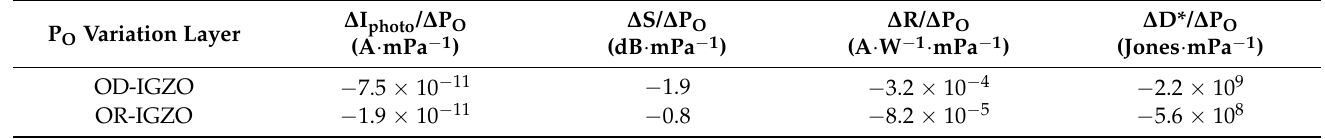
Figure 2. Dependence of the oxygen partial pressures for OD-IGZO on ( a ) I photo /S and ( b ) R/D* of the DSCL-TFTs; dependence of the oxygen partial pressures for OR-IGZO on ( c ) I photo /S and ( d ) R/D* of the DSCL-TFTs. Table 2. Variations of the UV light detecting performances with Δ P O for OD ‐ IGZO and OR ‐ IGZO.